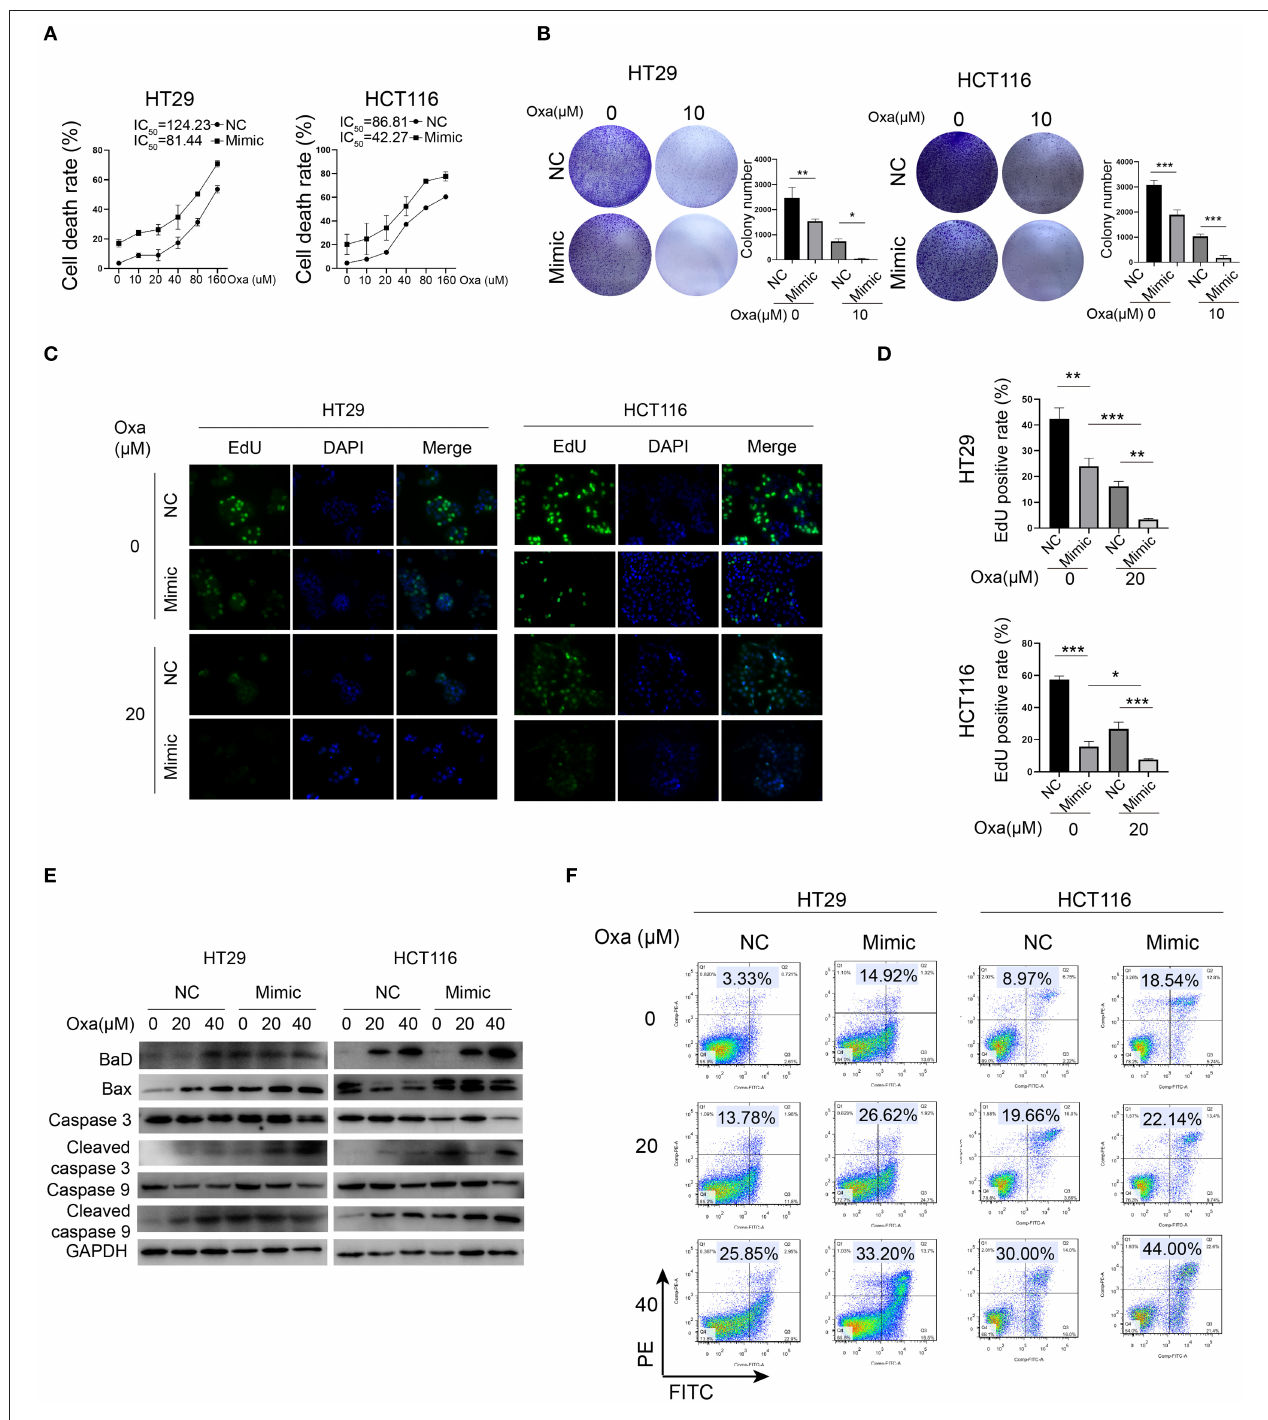
FIGURE 2 | miR-1278 mimic sensitizes CRC cells to oxaliplatin by inducing apoptosis. (A) Cell viability was detected by CCK-8 assay in HT29 and HCT116 cells treated with various concentrations of oxaliplatin for 24h. The IC50 values of the NC and miR-1278 mimic groups were 124.23 and 81.44 µ M, respectively, in HT29 cells as well as86.81 and 42.27 µ M, respectively, in HCT116 cells. (B) Cells (5,000 cells per well) were seeded and cultured for 3 days, and cells were then treated with oxaliplatin and cultured for another 4 days. The results showed that the miR-1278 mimic greatly inhibited colony formation of HT29 and HCT116 cells treated with 10 µ M oxaliplatin. (C,D) Transfection of miR-1278 significantly reduced the proliferation of HT29 and HCT116 cells treated with 20 µ M oxaliplatin as demonstrated by the EdU assay. (E) Comparison of the expression levels of caspase 3, cleaved caspase 3, caspase 9, cleaved caspase 9 and Bax and Bad